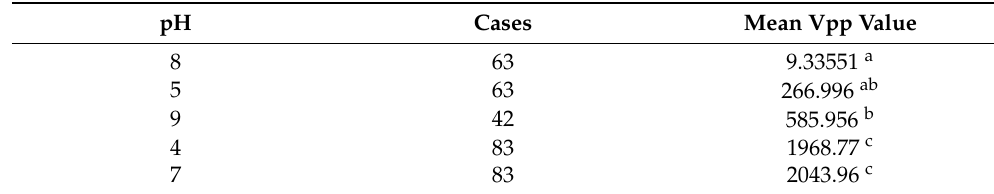
Table 15. Duncan’s Multiple Range Test for pH of Two-Way ANOVA results for Vpp with selected data.